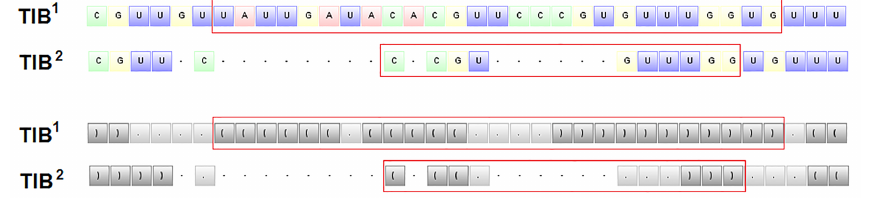
Fig. 3. The primary (upper) and secondary (lower) sequences in Helix II of ITS1 of Artemia tibetiana (boxes show the position of Helix II). TIB 1 : Haplotypes TIB2-5; TIB 2 : Haplotype TIB1. (Abbreviations of species/population are defined in Table 1).